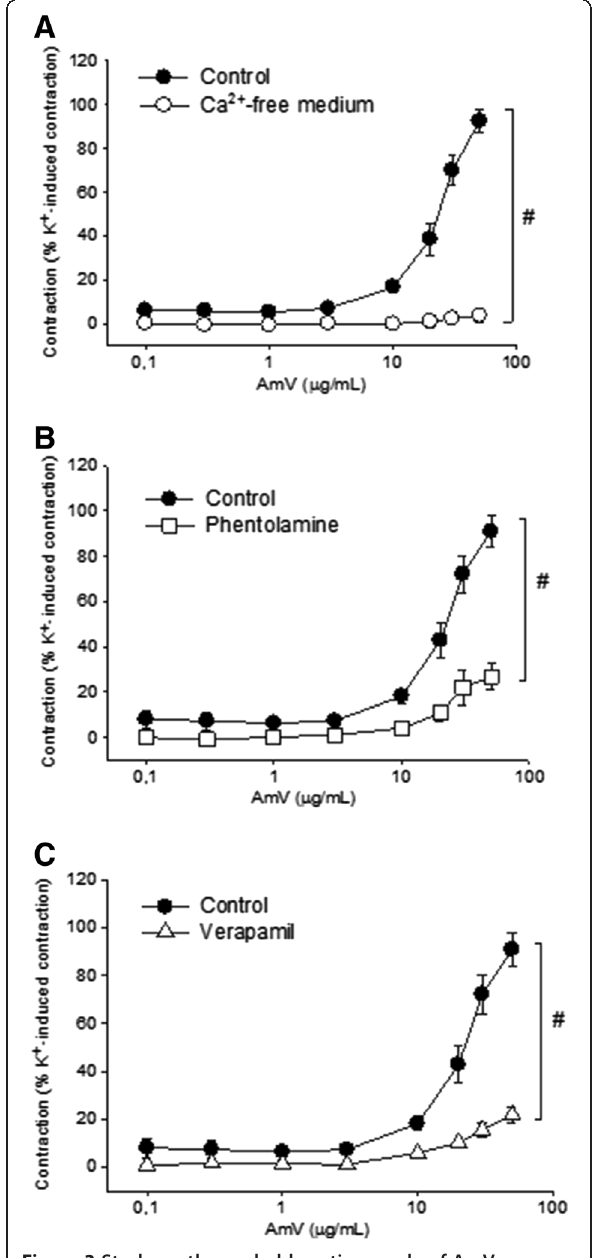
Figure 3 Study on the probable action mode of AmV. Vasoconstrictor effects of AmV: (A) Ca 2+ -free medium ( Ο , n = 5); (B) pretreatment with phentolamine (5 μ M; □ , n = 5); (C) pretreatment with verapamil (10 μ M; Δ , n = 5). Vasoconstrictor effects are expressed as a percentage of the contractile response to K + (60 mM). Data are expressed as mean ± SEM and analyzed by ANOVA followed by the Holm-Sidak